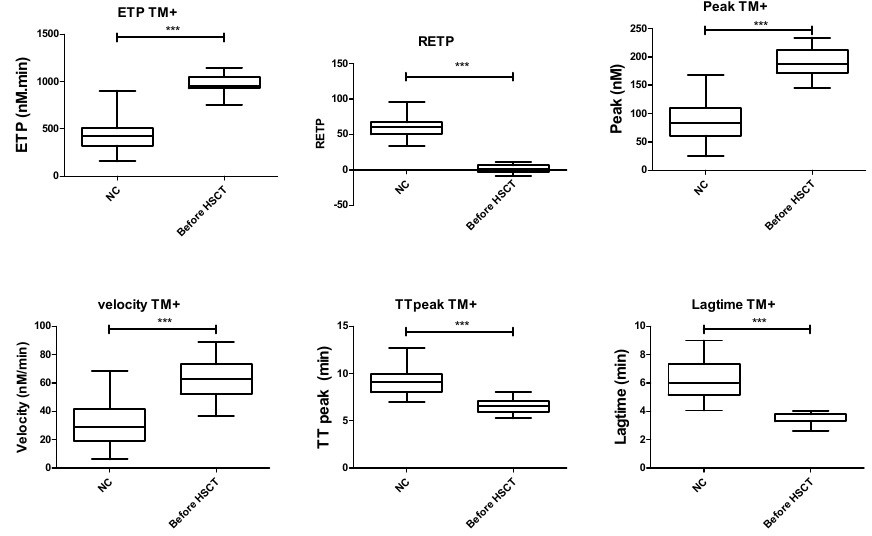
Figure 1. Comparison of the TG parameters with TM (median and range) between normal controls (NC) and sickle cell disease (SCD) patients before HSCT. ETP TM+: endogenous thrombin